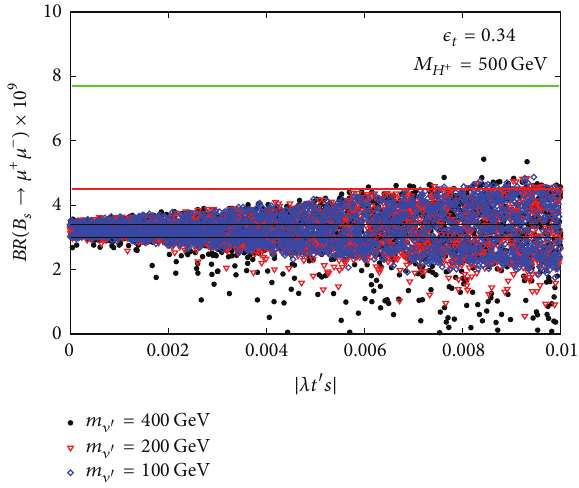
󸀠 ≡ 𝑉 𝑉 ∗ Figure 15: BR (𝐵 𝑠 → 𝜇𝜇) as a function of 𝜆 𝑡 𝑡 󸀠 𝑏 𝑏𝑠 𝑡 󸀠 𝑠 , from box diagrams with 𝐻 + and (𝑡, ] 󸀠 ) , (𝑡 󸀠 , ] 󸀠 ) exchanges in the 4G2HDMI. and 𝛿 Σ are varied within the constraints The parameters 𝛿 𝑈 2 2 imposed by 𝑎 𝜇 (see the previous section), keeping both of them ≲ 0.2. Also shown are the experimental 95% CL upper bounds from LHCb (red horizontal line) and from CMS (green horizontal line). The SM predicted range of values (at 1𝜎 ) is shown within the black horizontal lines. Figure taken from